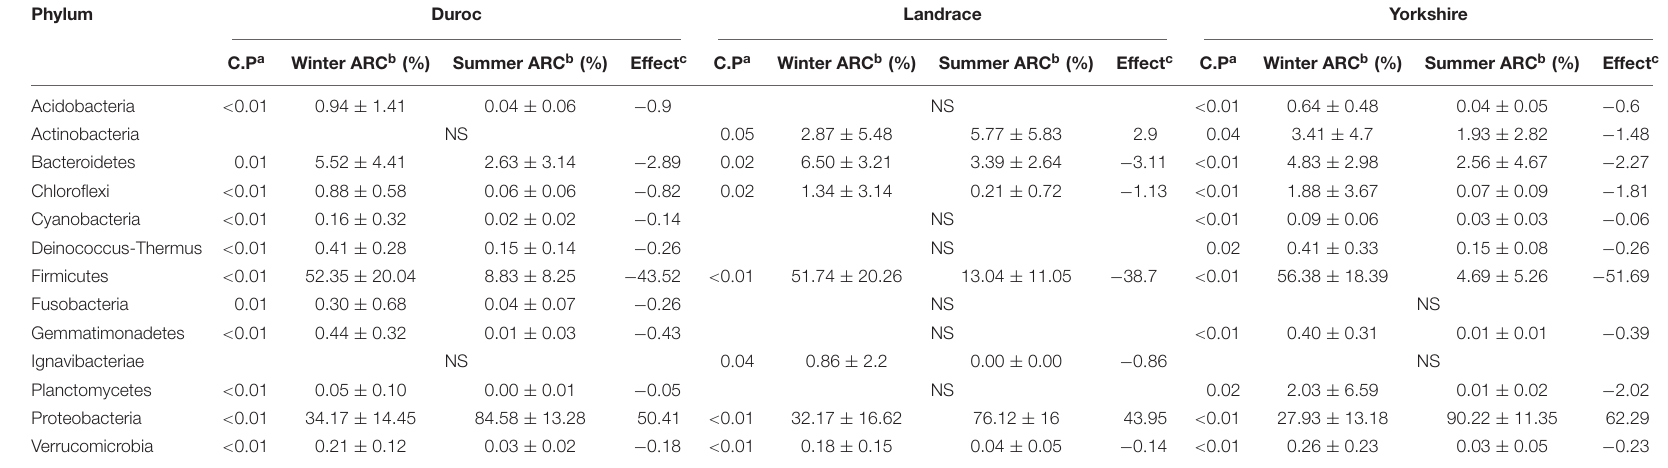
TABLE 1 | Semen bacteria with different abundance at phylum level in winter and summer.